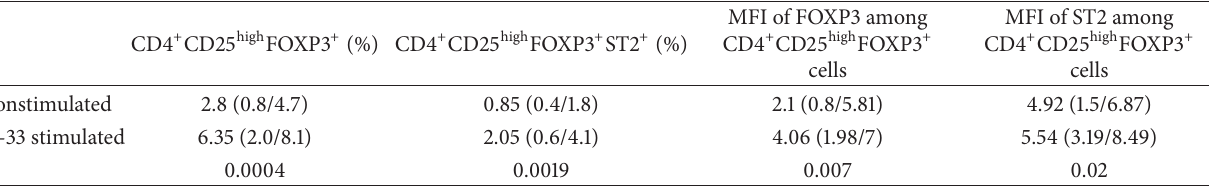
Table 2: The status of CD4 + CD 25 high FOXP3 + and CD4 + CD 25 high FOXP3 + ST2 + Treg cells after in vitro treatment with IL-33 in patients with type 1 diabetes.